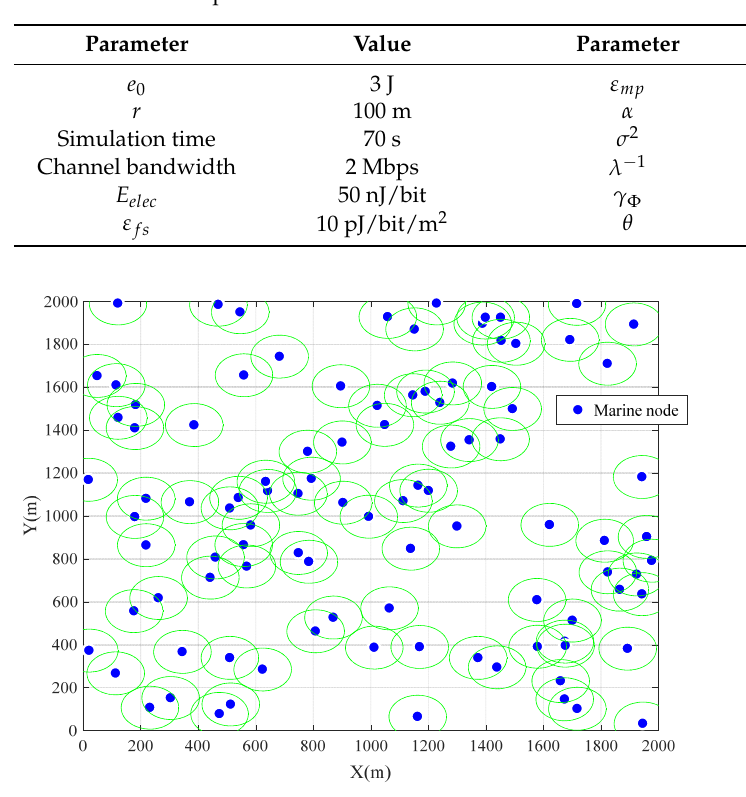
Figure 4. Marine nodes deployed in the MSR sea area.